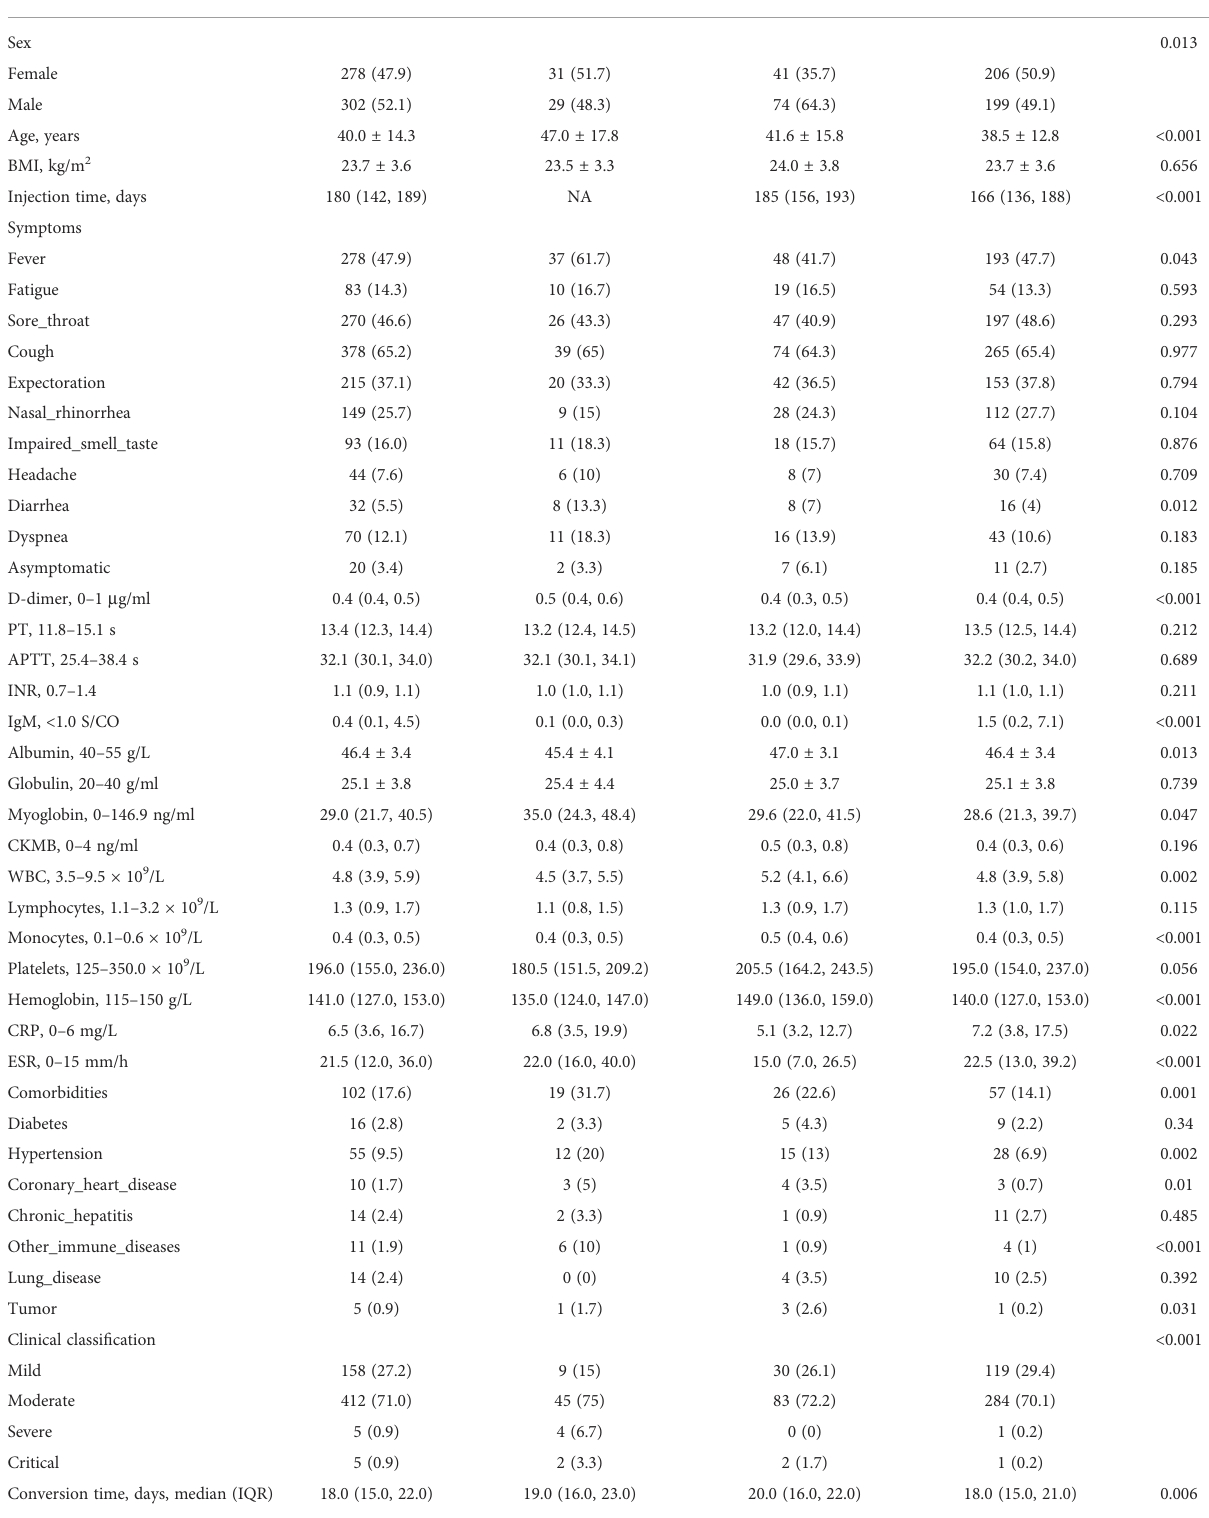
TABLE 1 Baseline characteristics of the